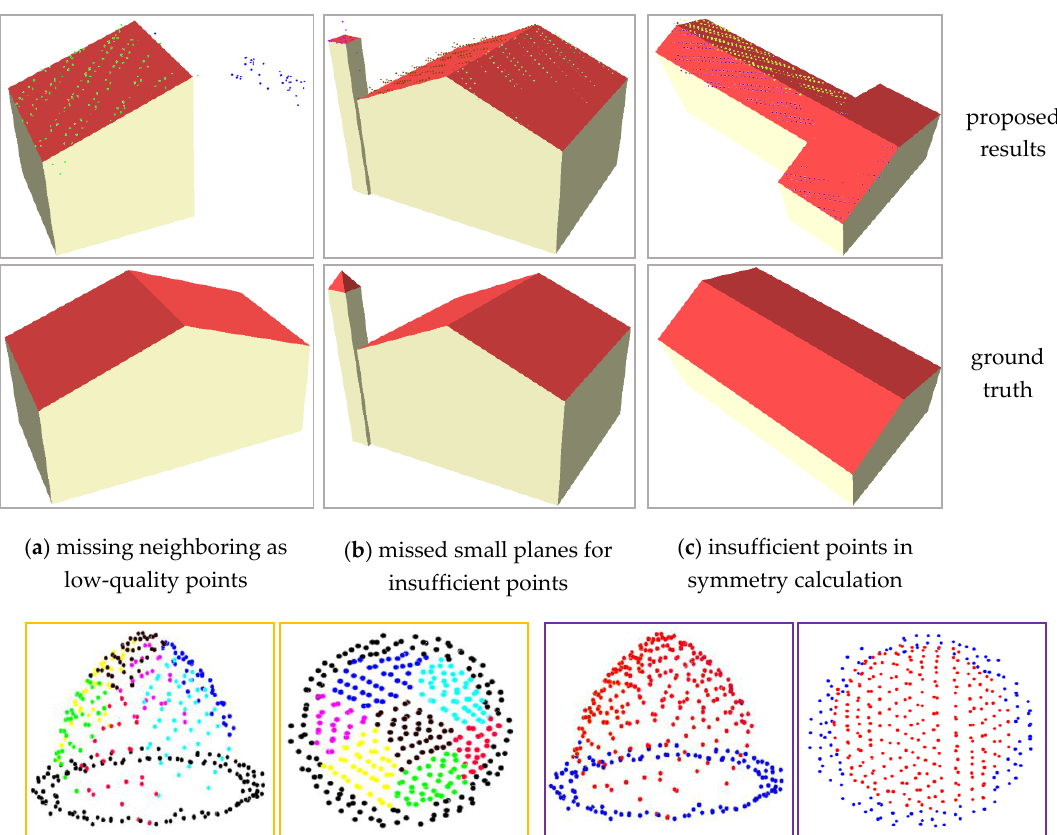
Figure 17. Results of the incomplete and failed reconstruction models. Building models in the top of ( a – c ) are the incomplete models with segmented roof points, and the bottom are the ground truth. In addition, the left two in ( d ) are the results of the plane segmentation, while the right two are the failed models expressed by colored grouped points.